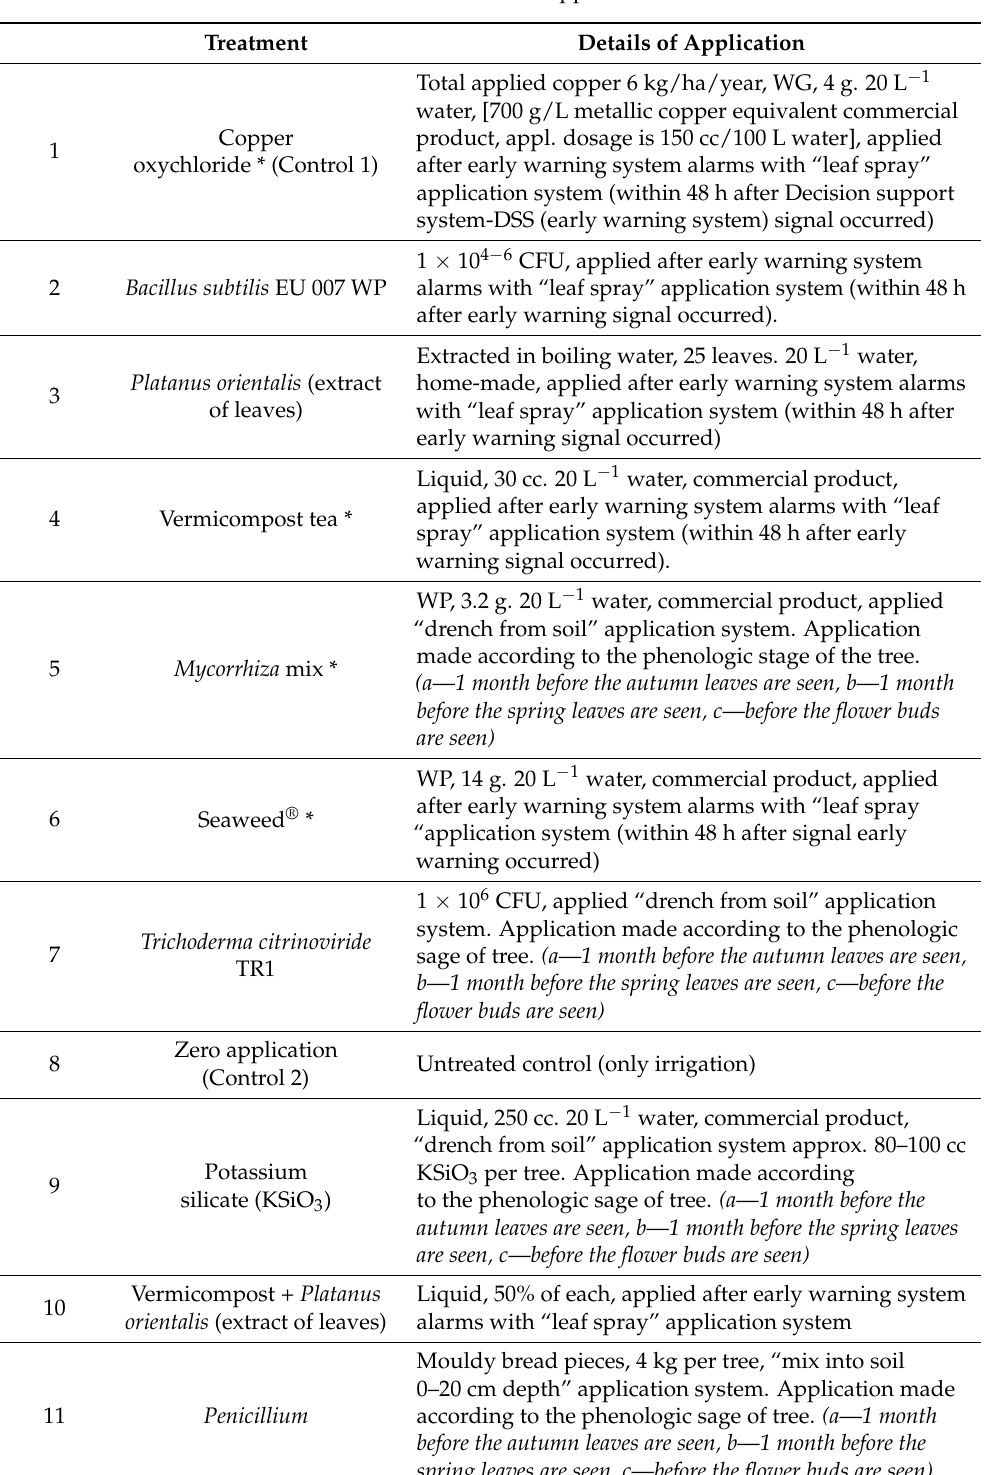
Table 2. Periods and doses of eleven treatments in the copper field